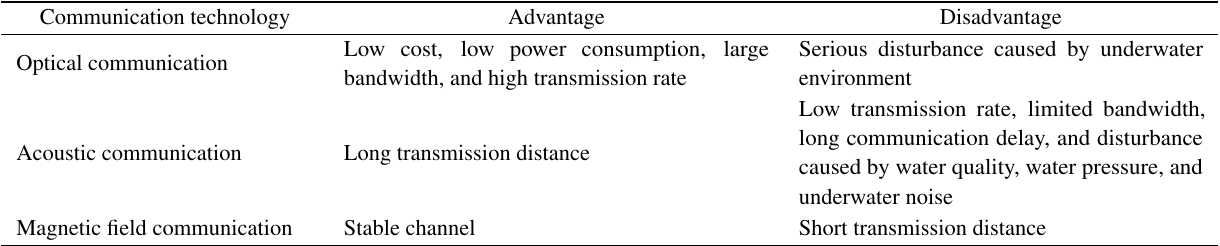
Table 1 Some advantages and disadvantages of different underwater communication technologies. Communication